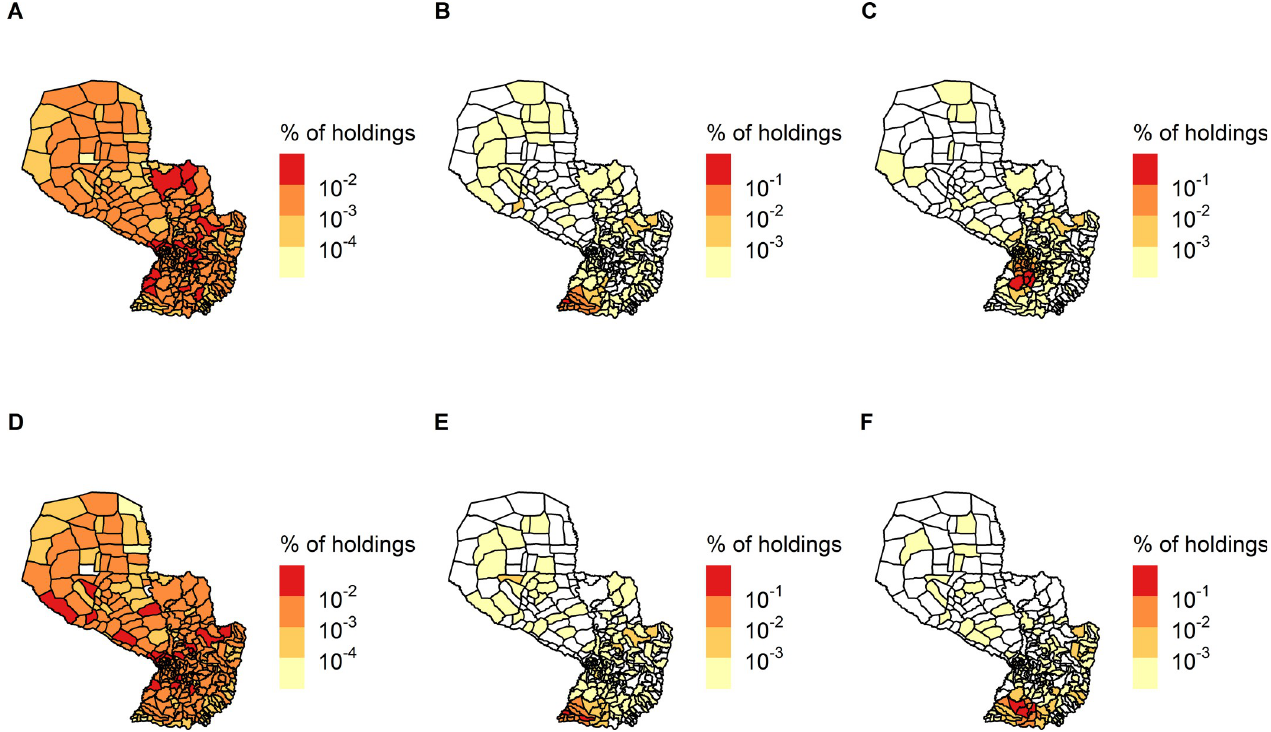
Fig 4. Spatial distribution of the first three communities of the global networks at the holding level. Communities (A-B-C): all cattle and (D-E-F): only cows in Paraguay (aggregated nodes and links from 2014 to 2018). Percentage of holdings in each district corresponds to the number of holdings belonging to the community over the size of that